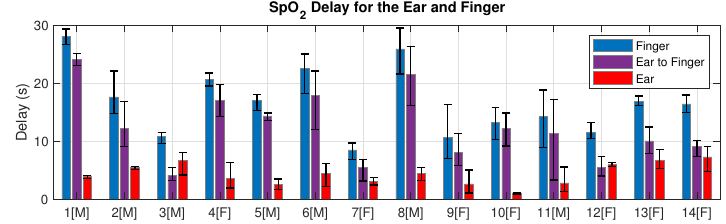
Figure 7. The absolute blood oxygen delay from the button press to the finger (blue), to the ear (red) and the relative delay between the ear and the finger (purple), shown for every subject. Male subjects are designated with [M] and female subjects with [F]. The delay is calculated from the time that the breath hold stops (true minimum blood oxygen) to the time at which the measuring site detects a minimum in SpO 2 . Error bars are included to show the range of the three delay measurements for individual